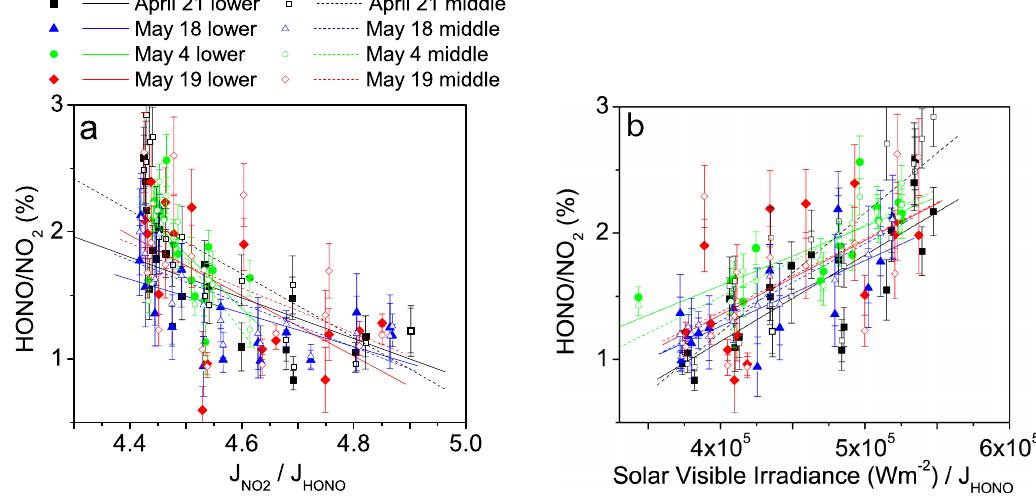
/ J HONO ratio (a) and solar visible irradiance/ J HONO (b) on four sunny 2